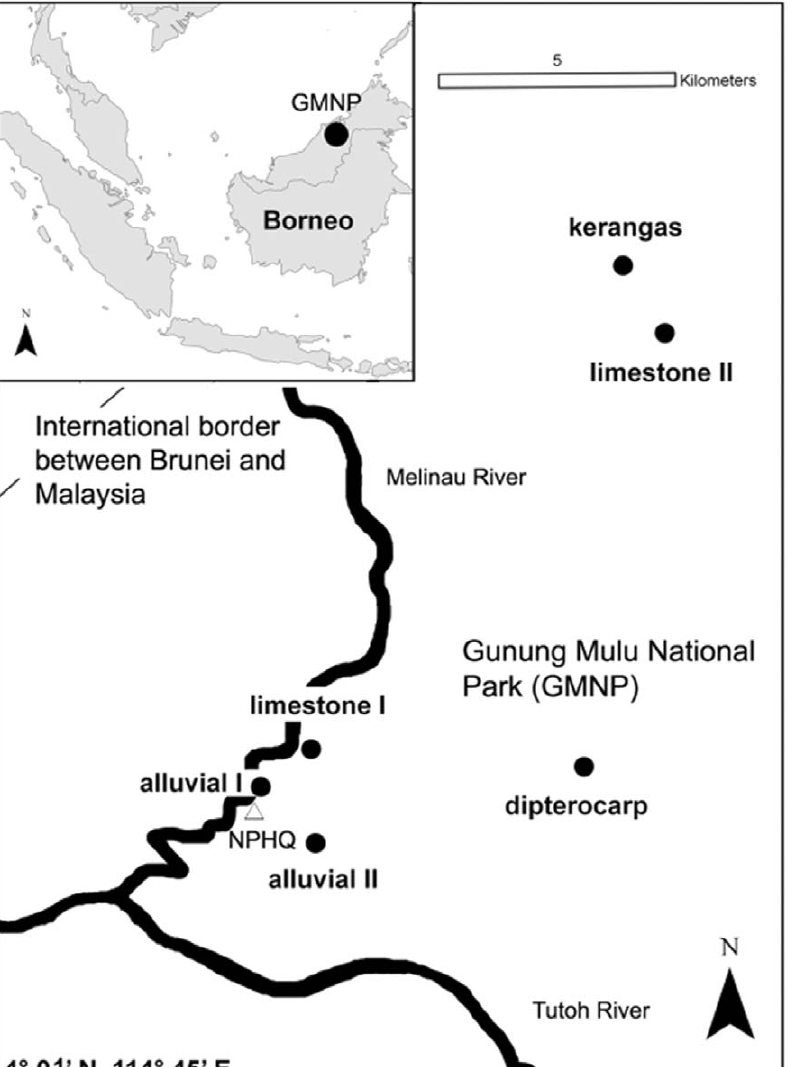
Figure 1. Location of the six transects in Gunung Mulu National Park. The position of the National Park’s headquarter (HQ) is marked with a white triangle. The coordinates on the map are at the lower-left corner. The inserted map shows the position of this protected area on Borneo.